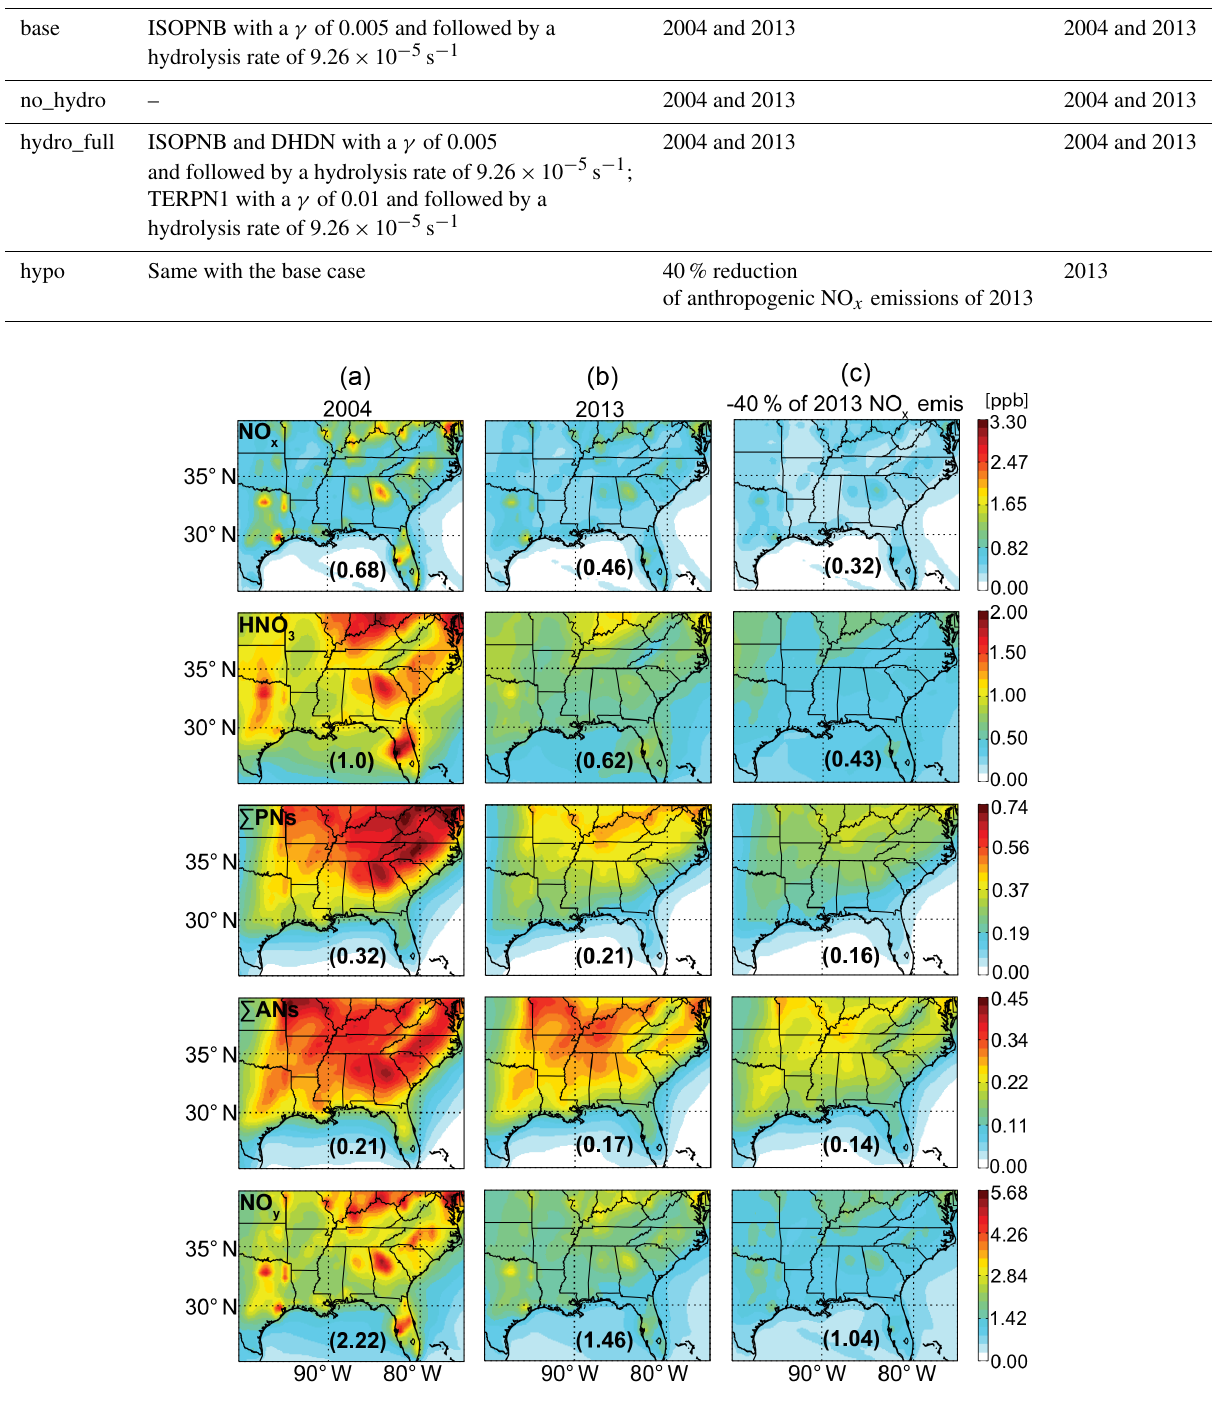
Figure 6. Modeled mean NO x , HNO 3 , total peroxy nitrates ( (cid:54) PNs), total alkyl nitrates ( (cid:54) ANs), and NO y averaged over the boundary layer (<1.5kmg) of the Southeast US during July–August of 2004 (a) , 2013 (b) , and a scenario assuming 40% reduction of 2013 anthropogenic NO x emissions (c) . Numbers in parentheses indicate mean concentrations over the plotted region. Note that different color scales represent the concentration of each